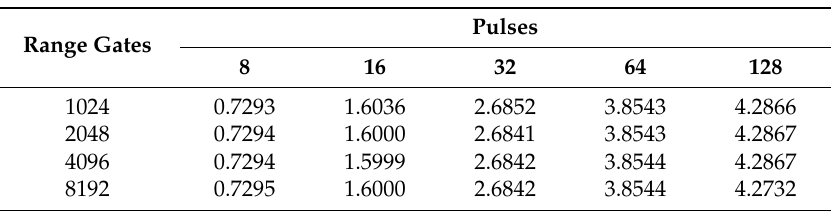
Table 3. Doppler filtering performance measured in GFLOPS per core.